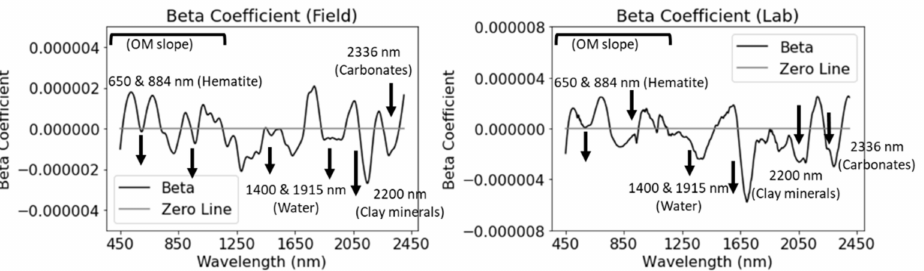
Figure 9. Beta coefficients of the PLSR models for the prediction of WIR using the samples of the sandy group, and the ASD spectral